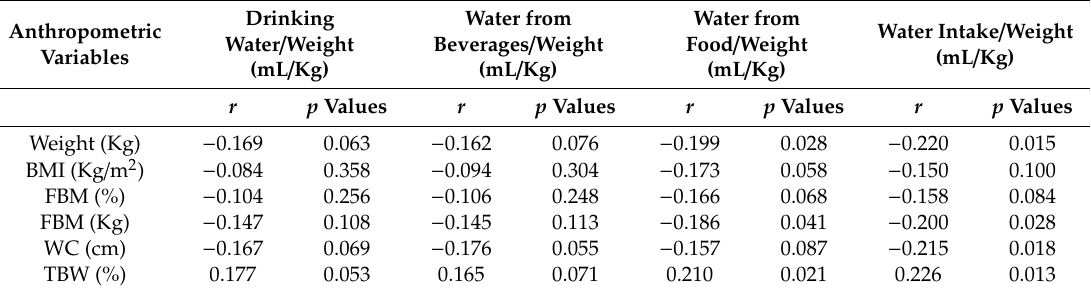
Table 3. Correlation between water intake normalized by body weight from all the sources analyzed with anthropometric and body composition variables of males.